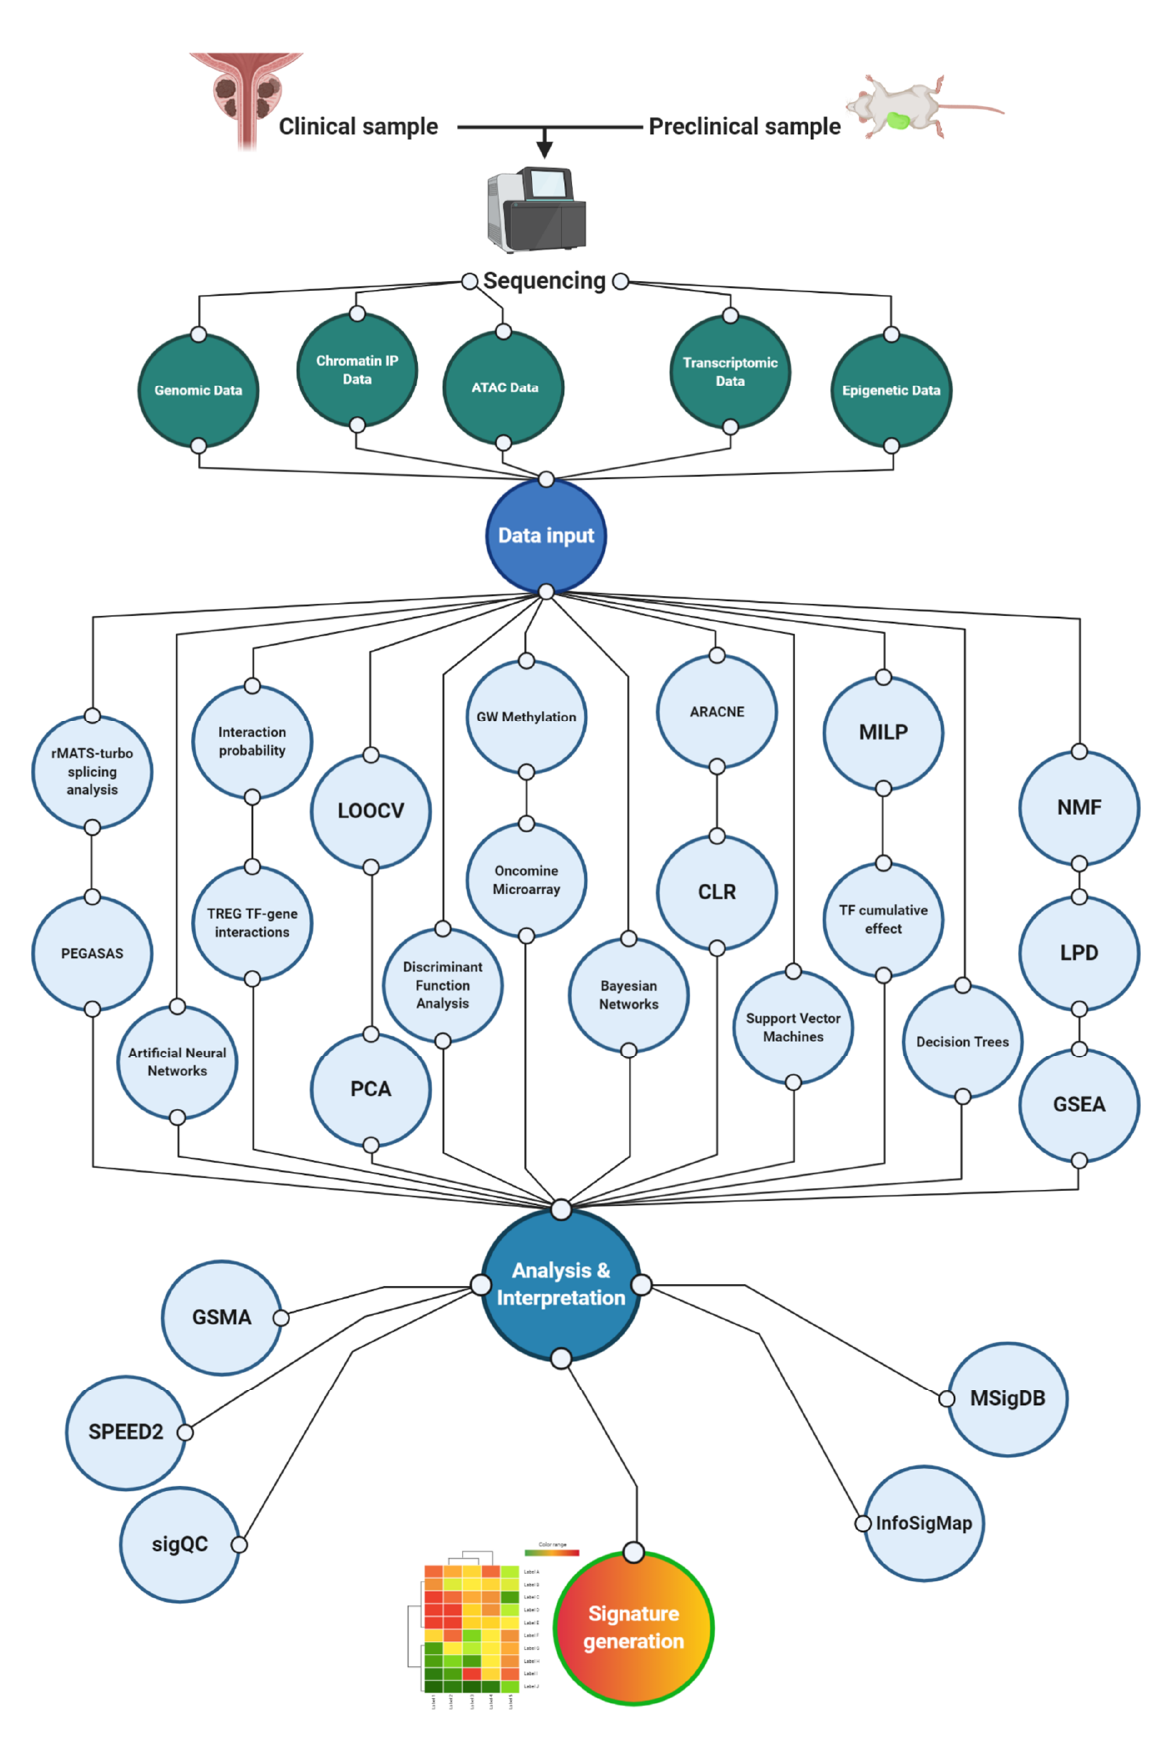
Figure 2. Overview of tools used in activity signature generation. A multitude of tools are used in generating activity signatures in cancer generally and in PCa particularly. These clusters are a representative, non-exhaustive range of tools used in PCa studies mentioned in this review. Consequently, they are forming workflows according to examples cited in this manuscript; that is not to say that the paths across these workflows are not routinely integrated to produce